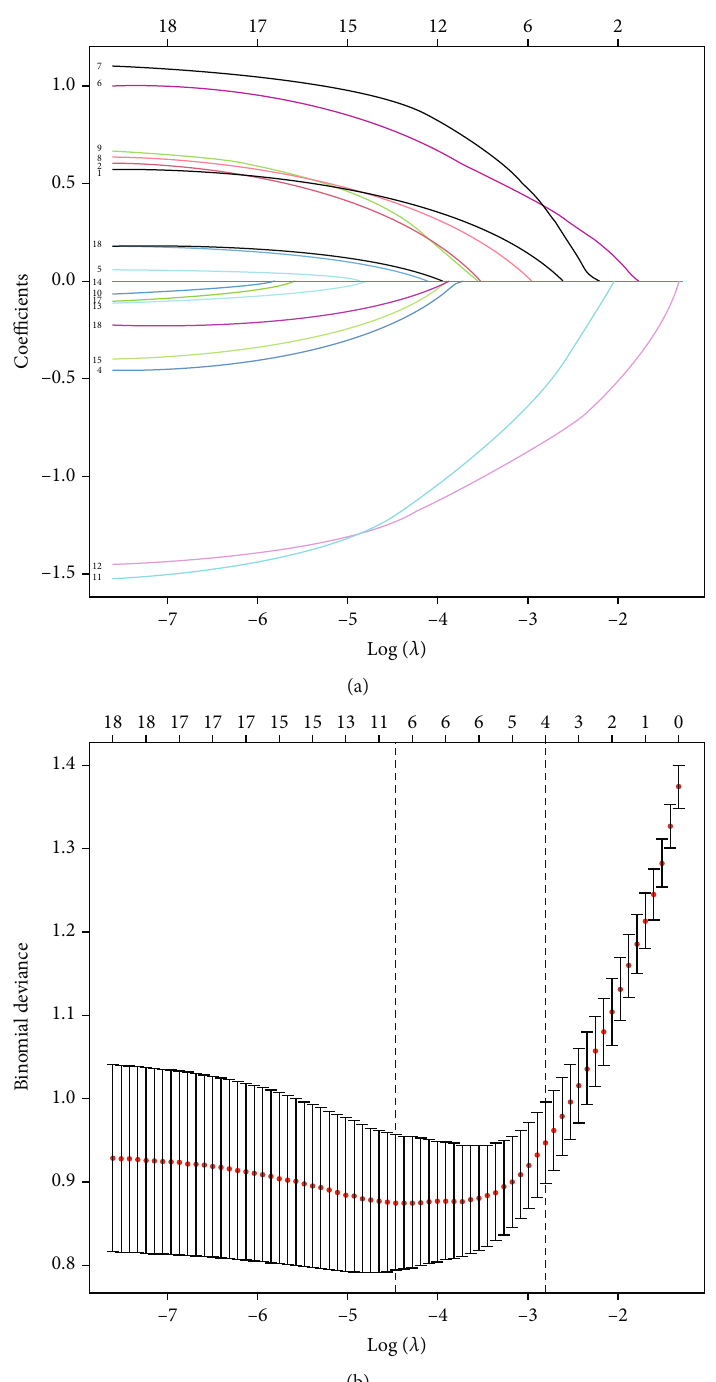
Figure 2: Results of the LASSO regression analysis. (a) LASSO coe ffi cient pro fi les of the 18 features. (b) Feature selection in the LASSO. Dotted vertical lines were drawn at the optimal